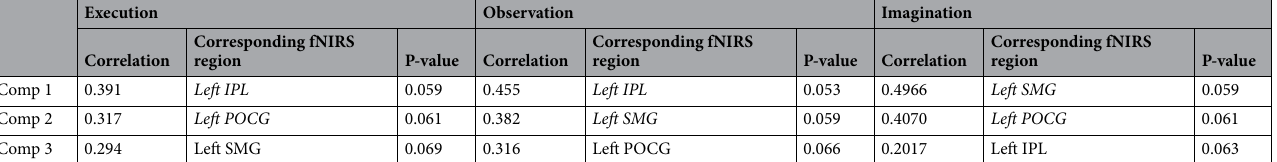
Table 1. Cross-modality correlations and associated p -values during ME, MO, and MI.